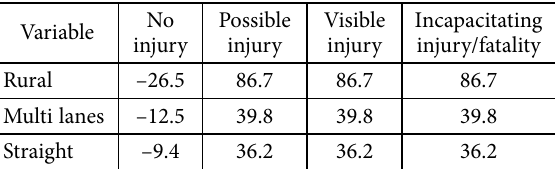
Table 7. Average variable pseudo